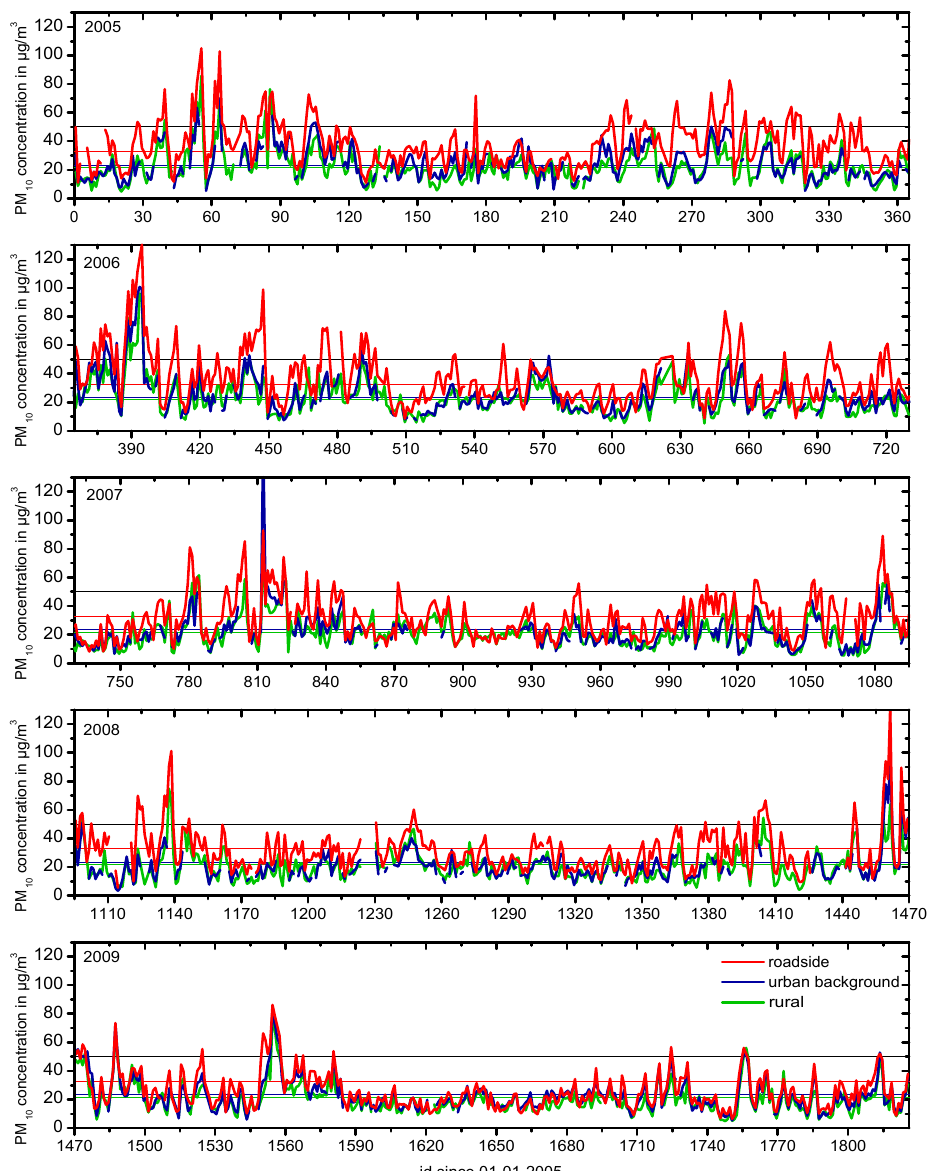
Fig. 2. Daily average PM 10 concentrations at the three measurement sites (roadside, urban background, rural background) during 2005–2009. Colored lines indicate the average values over the entire period for each station; the black line displays the limit value of 50µgm − 3 .